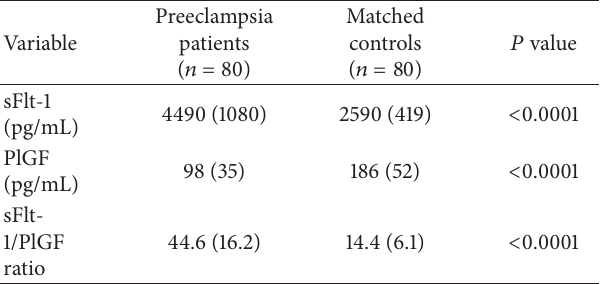
Table 2: Maternal plasma concentrations of sFlt-1, PlGF, and sFlt- 1/PlGF ratio in women who developed preeclampsia and in controls.